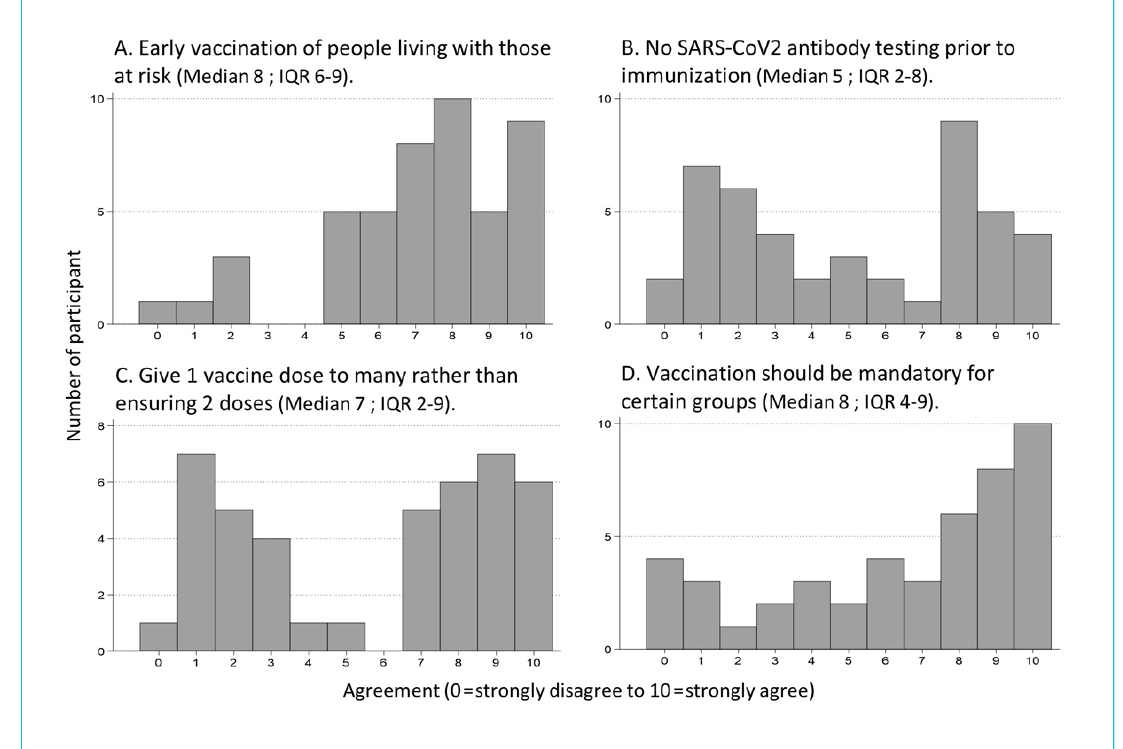
Figure 3: Distribution of responses for agreement with four selected statements not reaching